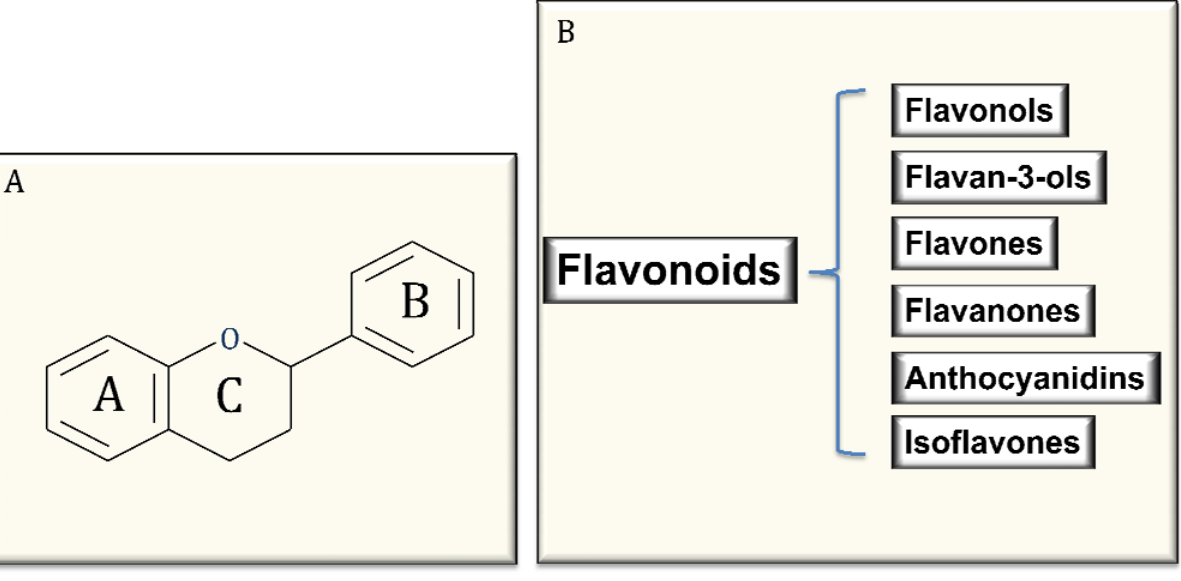
Figure 1 . Common structure of flavonoids (A) and classification